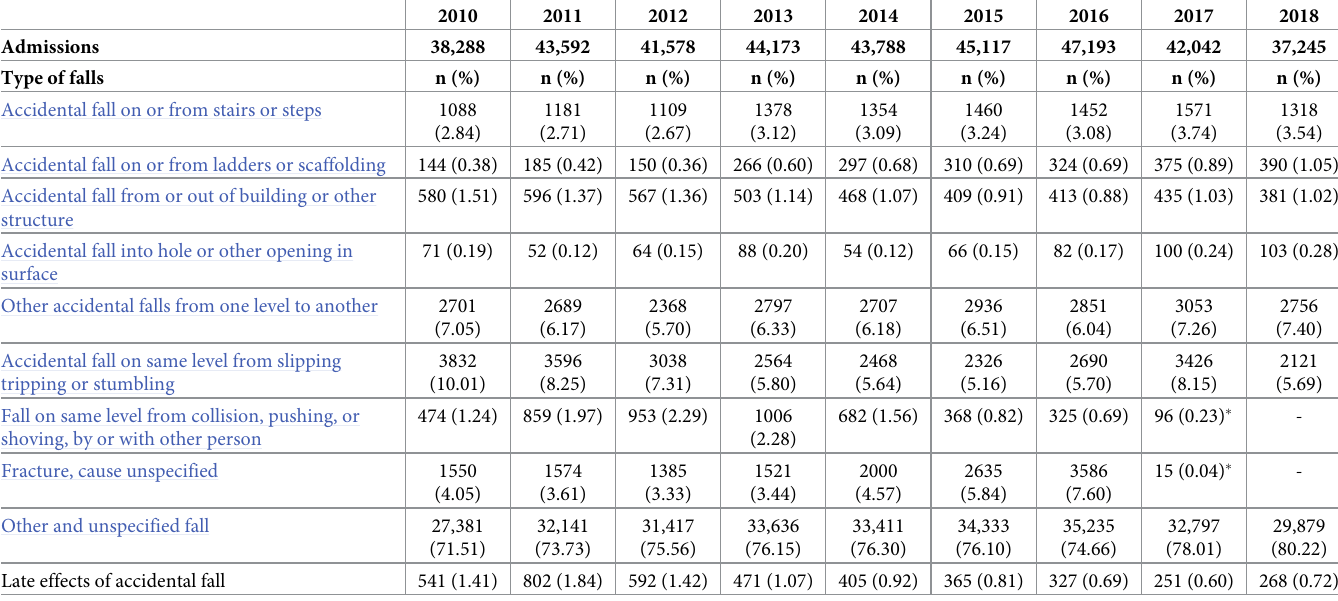
Table 4. Number of fall-related admissions by type of fall, in the Portuguese